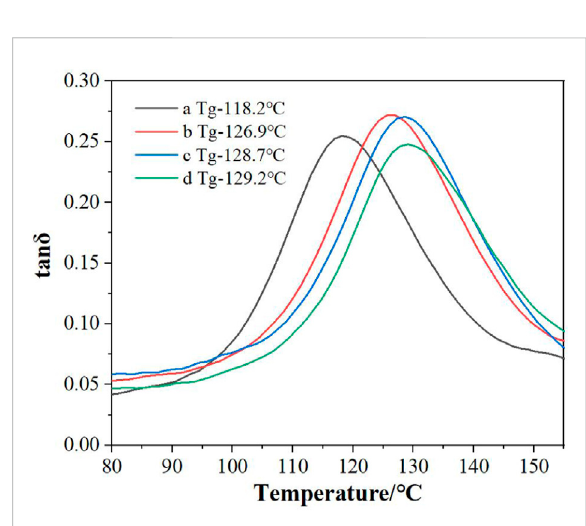
FIGURE 11 The effect of curing time on glass transition temperature